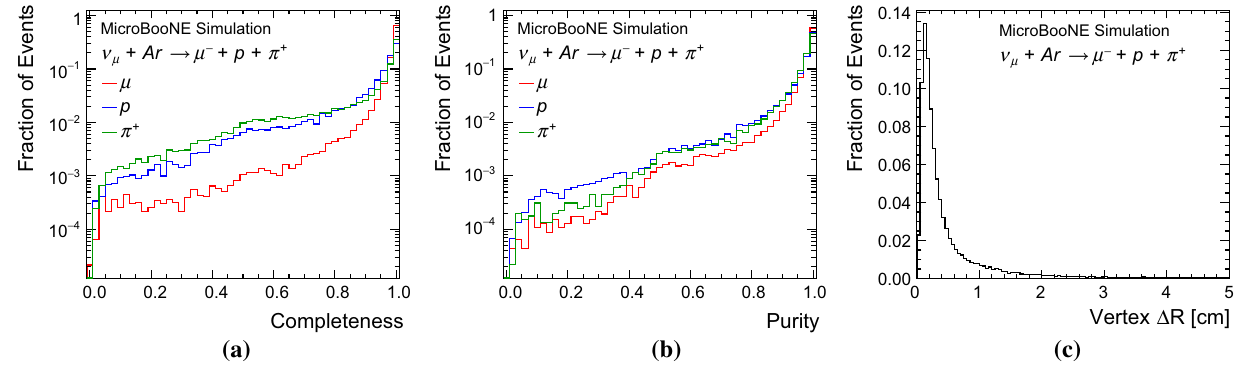
Fig. 15 Reconstruction efficiencies for the target muon, proton and charged pion in simulated BNB CC ν μ interactions with resonant pion production, a as a function of the numbers of true hits, b as a function of true momenta and c as a function of the true opening angles to the